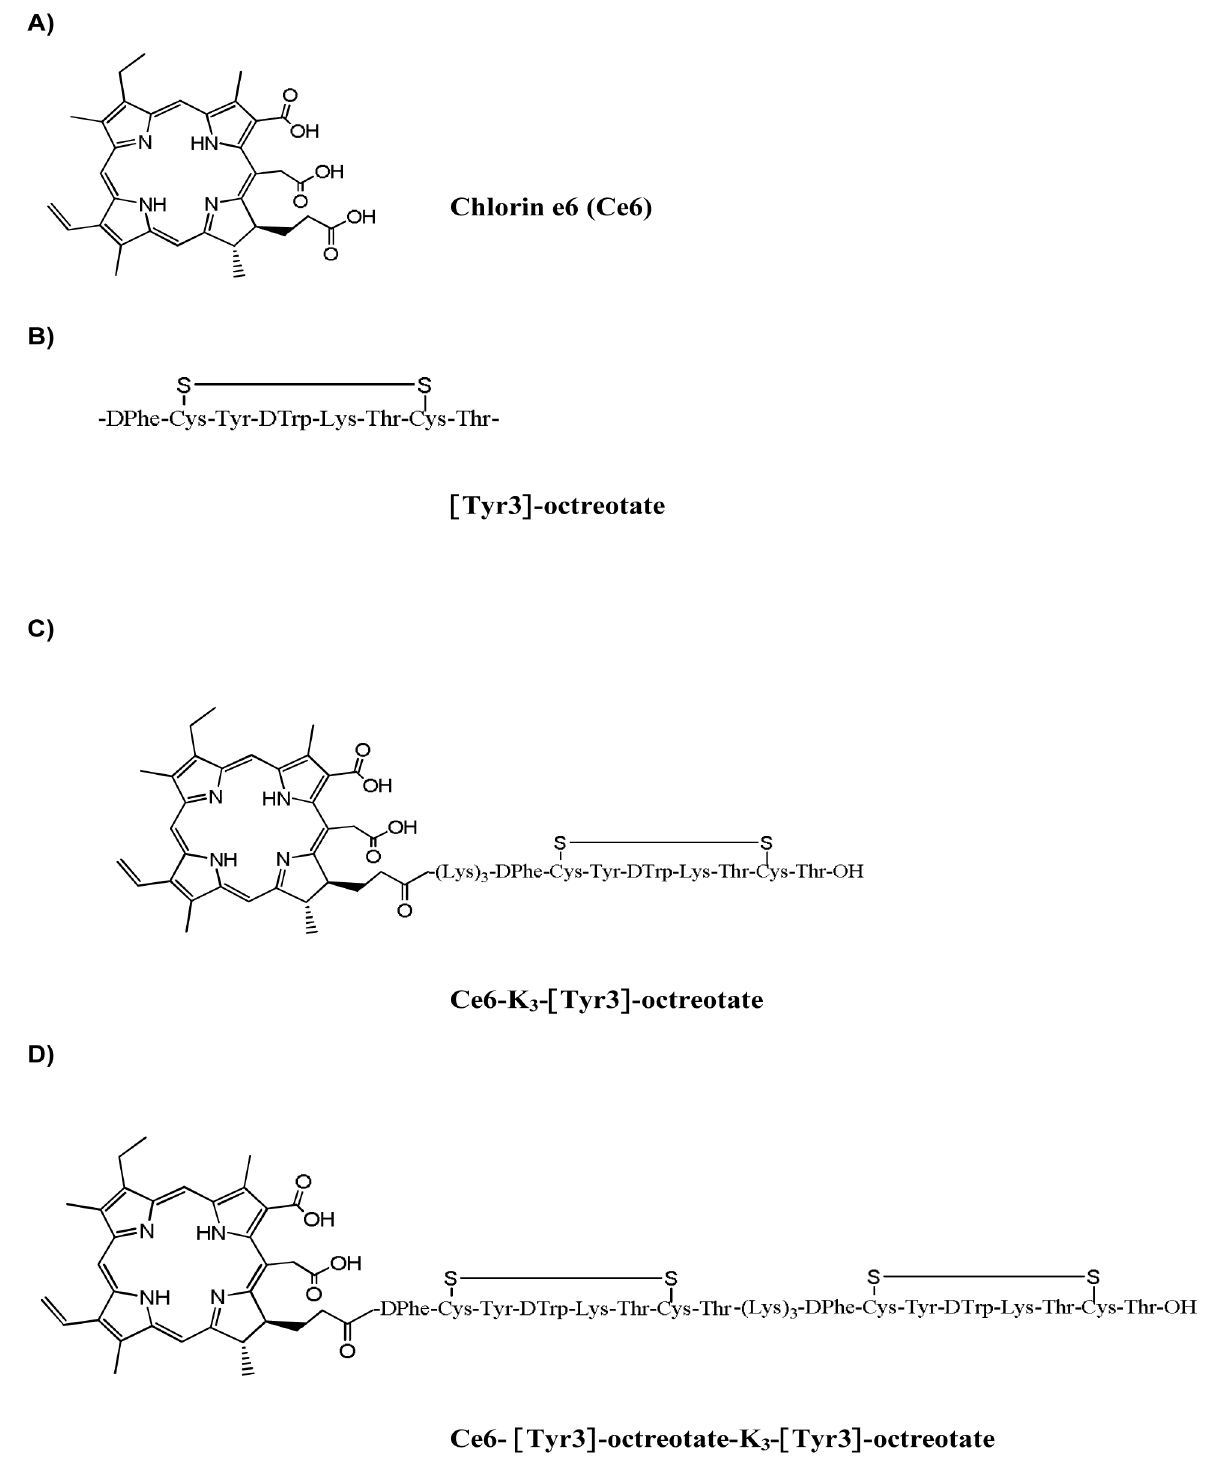
Figure 1. Structures of Ce6 and its two [Tyr3]-octreotate conjugates. (A) Ce6; (B) [Tyr3]-octreotate motif; (C) Ce6-K 3 -[Tyr3]-octreotate (conjugate 1 ) and (D) Ce6-[Tyr3]-octreotate-K 3 -[Tyr3]-octreotate (conjugate 2 ). A tri-lysine linker (K 3 ) was used between Ce6 and [Tyr3]-octreotate motifs to improve the hydrophilicity of the monomeric conjugate 1 . A similar linker was also inserted between the two [Tyr3]-octreotate motifs in the dimeric analog, conjugate 2 .